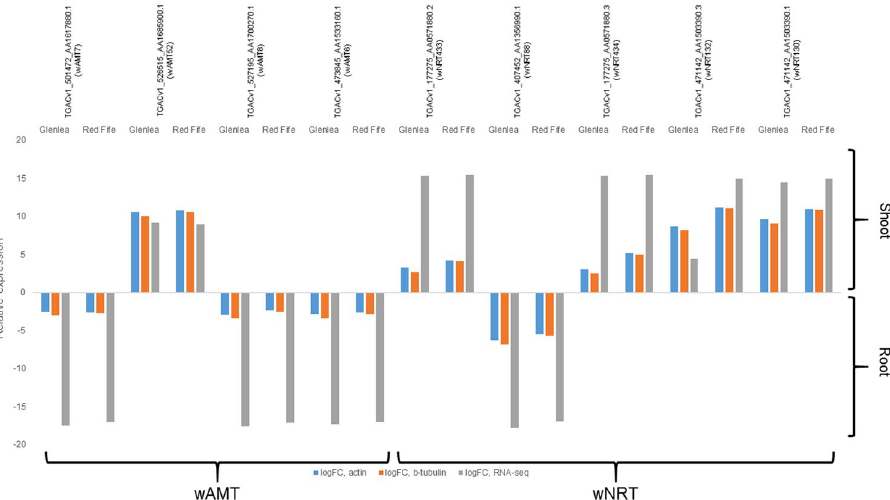
Figure 2. Expression of 9 differentially expressed wheat ammonium (wAMT) and nitrate (wNRT) transporter genes in lines Glenlea and Red Fife. Results from qPCR are means of three biological replicates per line, and are shown in reference to expression of actin and β -tubulin genes; whereas the results from RNA-seq are obtained after normalizing genes against libraries of all five lines. A higher relative expression value in shoot (above X-axis) indicates that the gene was highly expressed in shoot relative to root tissue and a smaller relative expression value in root (below X-axis) indicates that the gene was highly expressed in roots relative to shoot